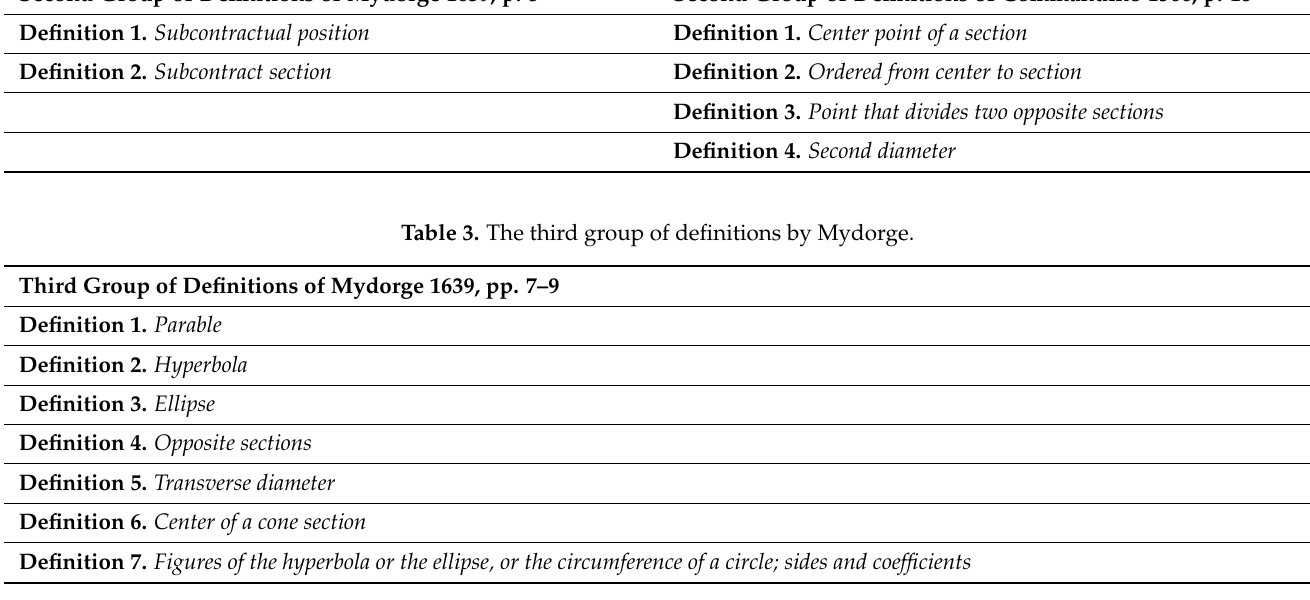
Table 2. Comparison between the second group of definitions by Mydorge and Apollonius. Second Group of Definitions of Mydorge 1639, p. 5